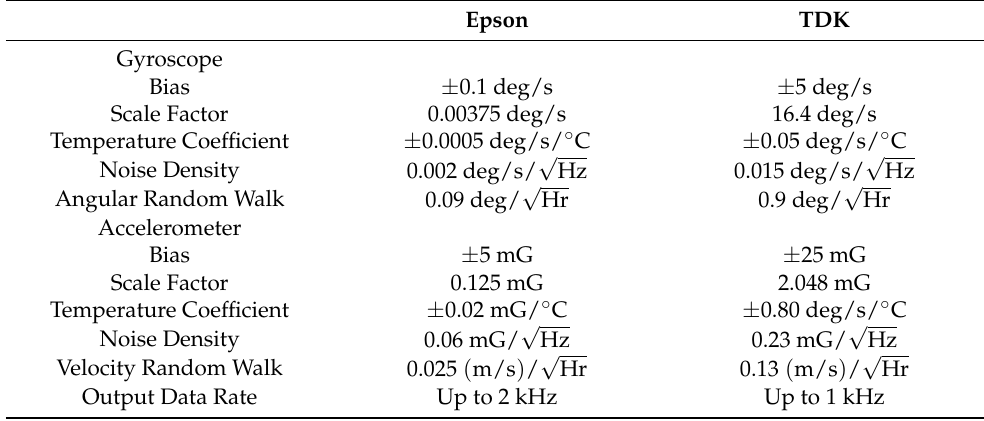
Table 1. Specifications EPSON and TDK IMUs.